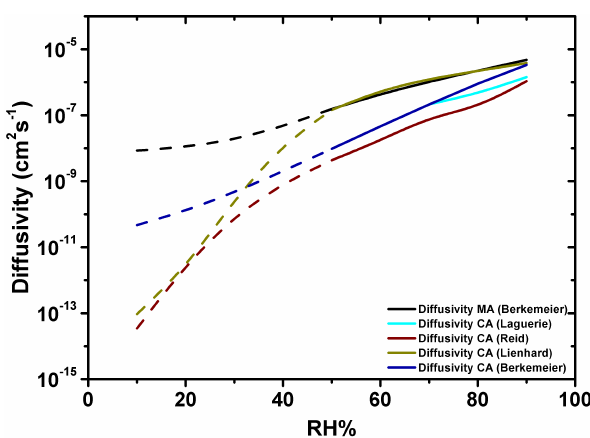
Figure 4. Diffusivity of N 2 O 5 in malonic and citric acid solutions as calculated according to four parameterization methods – black: Berkemeier (for malonic acid); teal: Laguerie; red: Reid; green: Lienhard; blue: Berkemeier; see text for details. Calculated values for a RH range between 10 and 90% can be found in Table S2 of the Supplement.